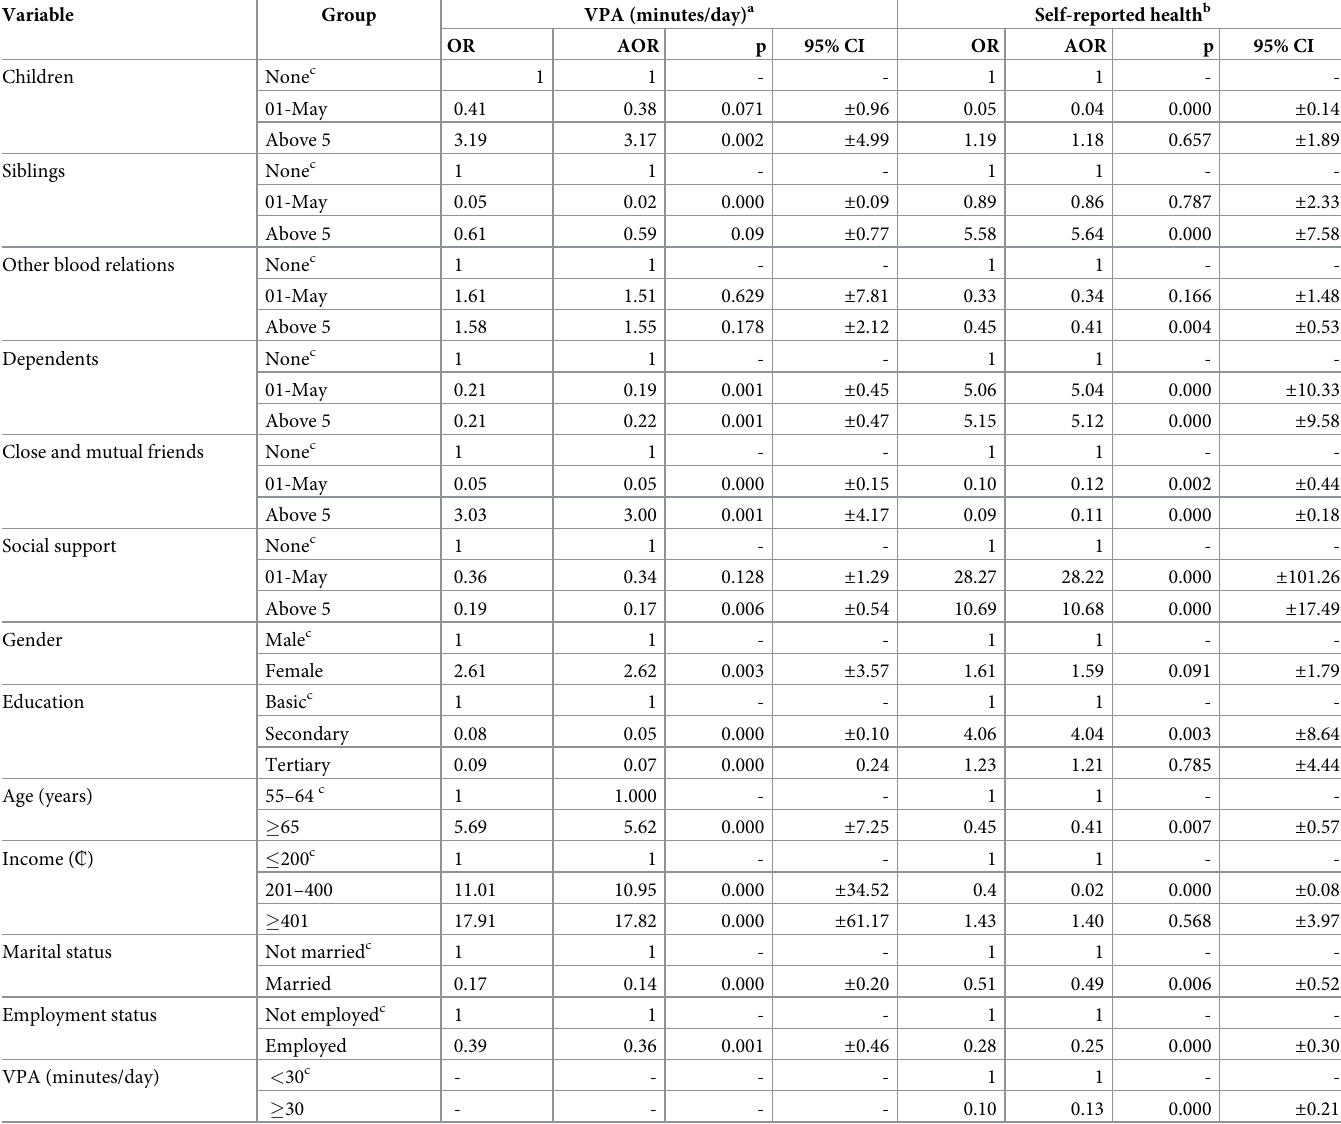
Table 2. The association between social ties, social support, VPA, and self-reported health. Variable